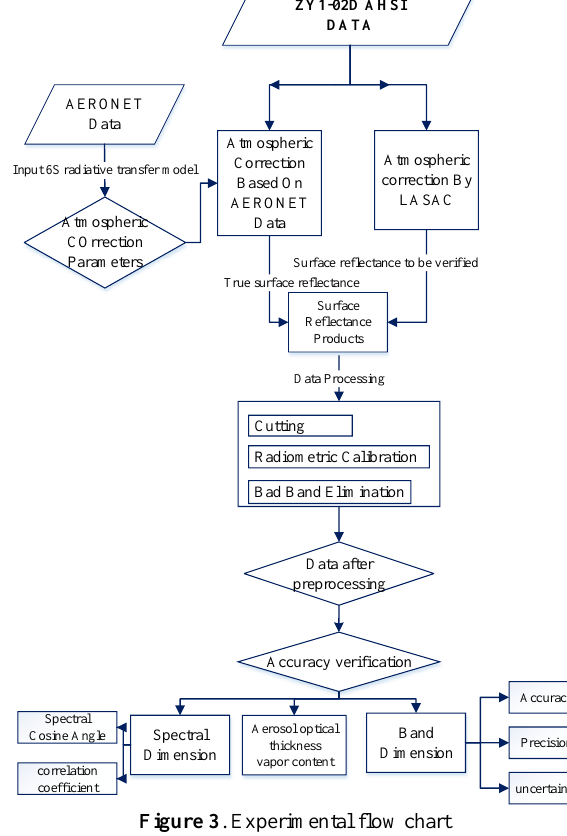
Figure 3 . Experimental flow